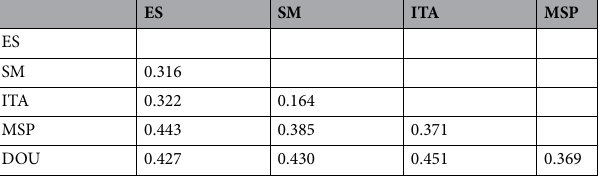
Table 5. Pairwise F ST among native populations of Schinus terebinthifolia collected from five ecoregions in the Atlantic Forest biome. ES, São Mateus ES; SM, Santa Maria RS; ITA, Itaparica BA; MSP, Morro de São Paulo BA; DOU, Dourados